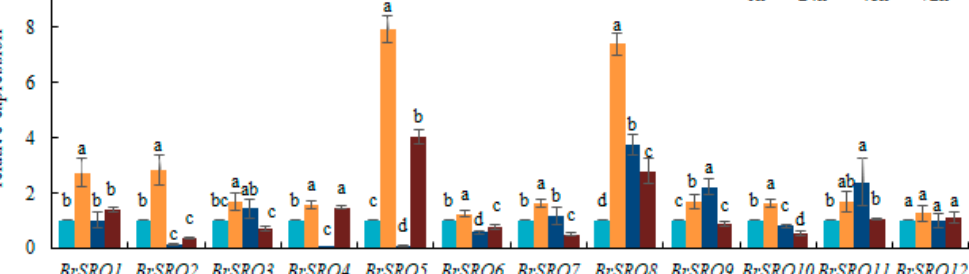
Figure 5. Expression profiles of 12 BrSRO genes in response to high temperature treatment, low-temperature treatment, drought treatment, and salt treatment. Quantitative reverse transcription polymerase chain reaction (qRT-PCR) analyses were used to assess the transcript levels of BrSROs in leaves sampled at 24 h, 48 h and 72 h after high temperature, low-temperature treatment, drought, and salt treatment in Chinese cabbage seedlings. 0 h as control. Three sets of repeats are set for each process. Error bars indicate standard deviations of three replicates and different letters describe significant differences at p ≤ 0.05 level among different time points within the same gene.